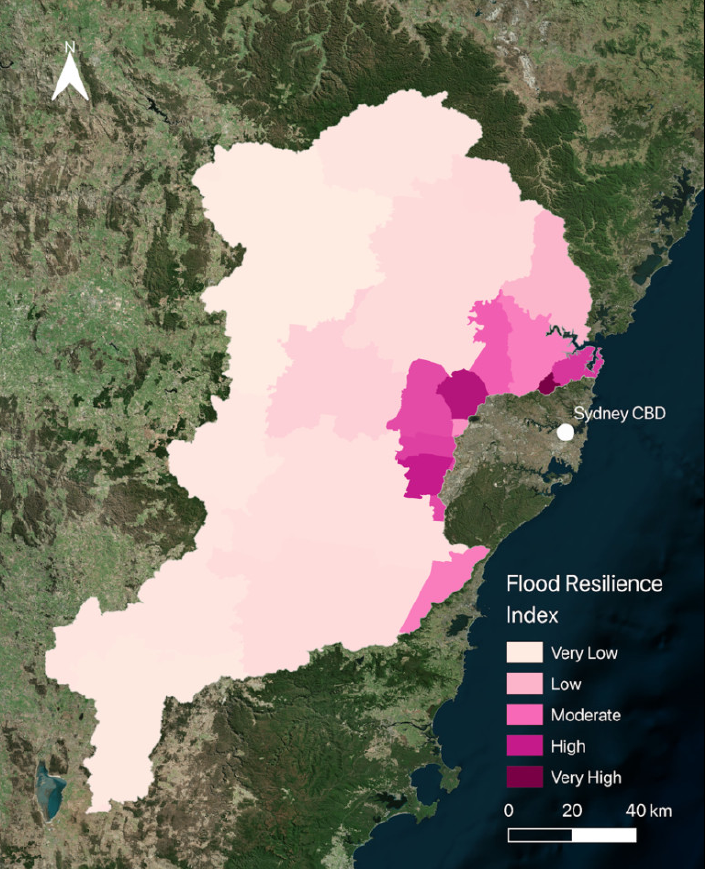
Figure 12. The Flood Resilience Index for the Hawkesbury-Nepean Catchment. Darker areas indicate greater flood resilience.